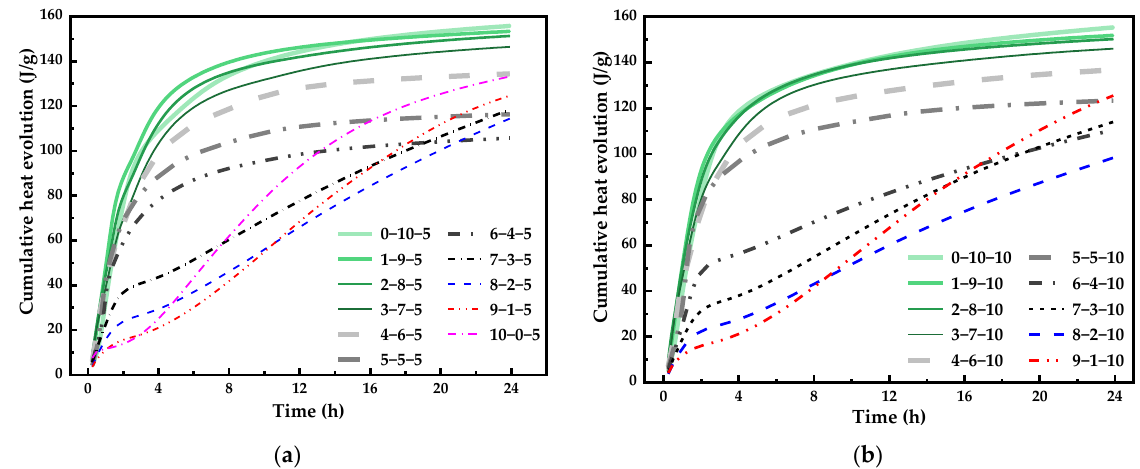
Figure 3. Cumulative hydration heat evolution of ternary blends with different CS contents: ( a ) with 5% CS; ( b ) with 10% CS.